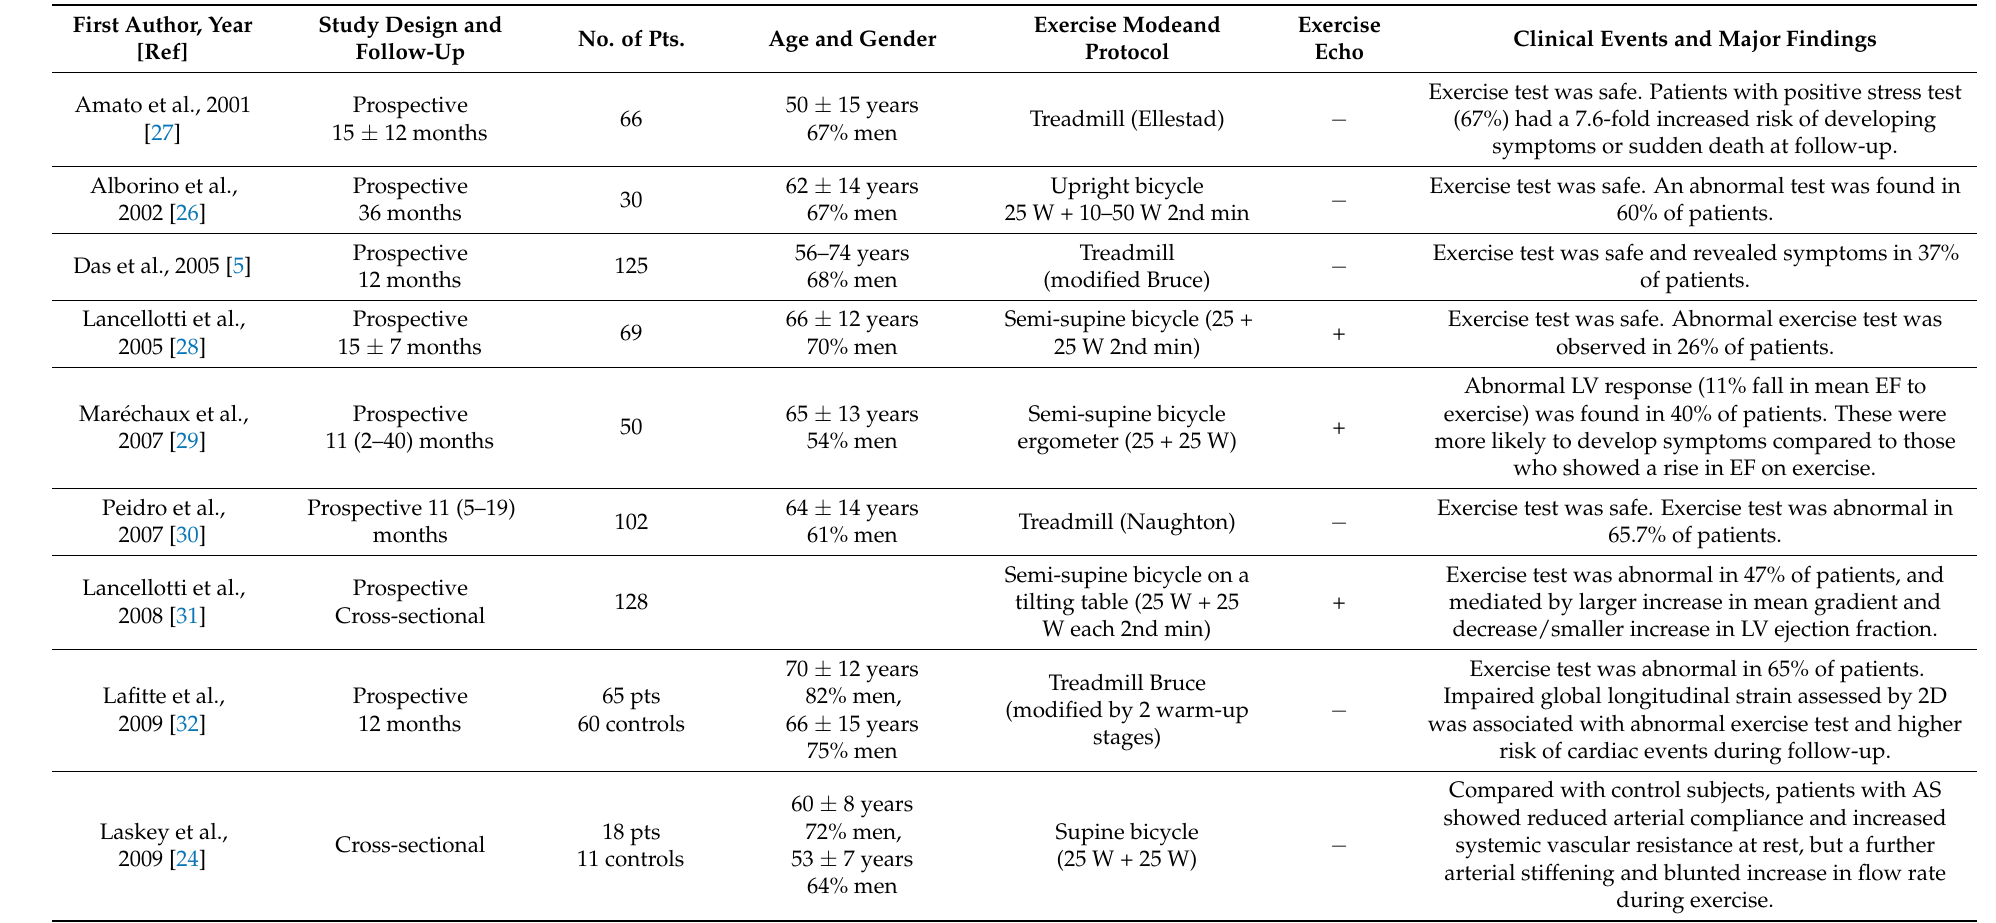
Table 3. Exercise stress test studies in patients with moderate or severe aortic stenosis